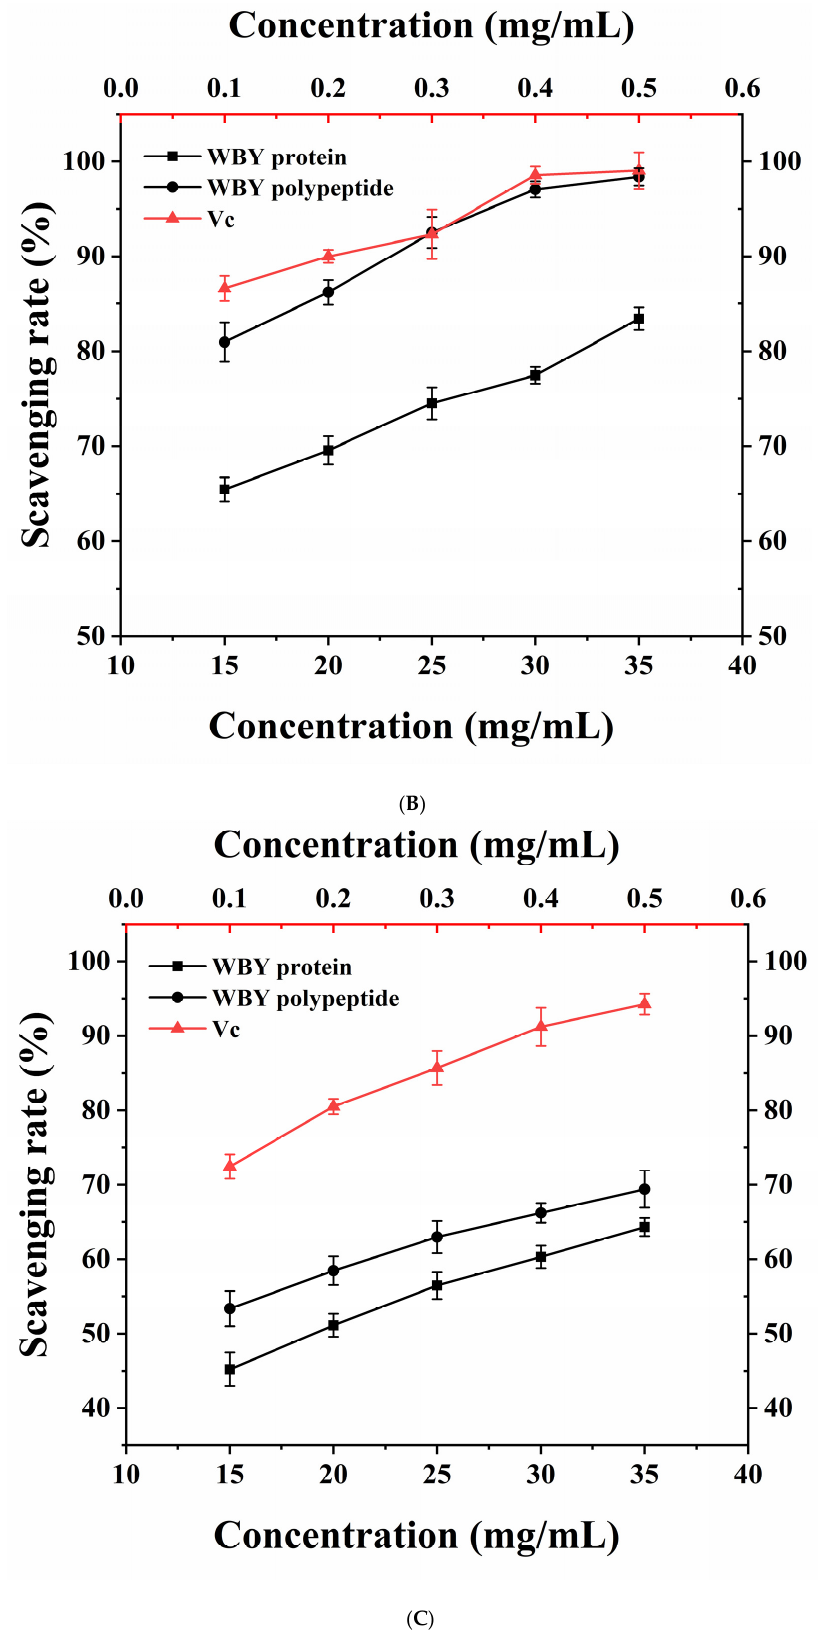
Figure 6. Antioxidant activity against hydroxyl radical ( A ), DPPH radical ( B ) and ABTS radical ( C ).